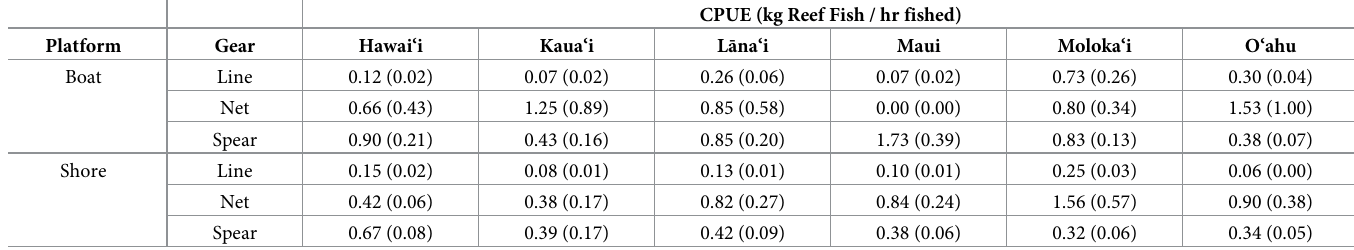
Table 3. Recreational CPUE per island, platform, and gear. Data shown are mean and standard error (SE) of CPUE by island for each combination of island, platform, and gear in intercept surveys by MRIP between 2004–13. Eqs 3 and 4 were used to calculate mean and variance of CPUE values. Reef fishes are taxa as defined in S1 Table. Note that as there were no intercept surveys on Lāna‘i, CPUE data for there are assumed to be the average from other islands. Lāna‘i CPUE SE was generated using the average precision (SE/mean) from all other islands. The number of catch interviews per combination of island, platform, and gear is given in S3 Table. CPUE (kg Reef Fish / hr